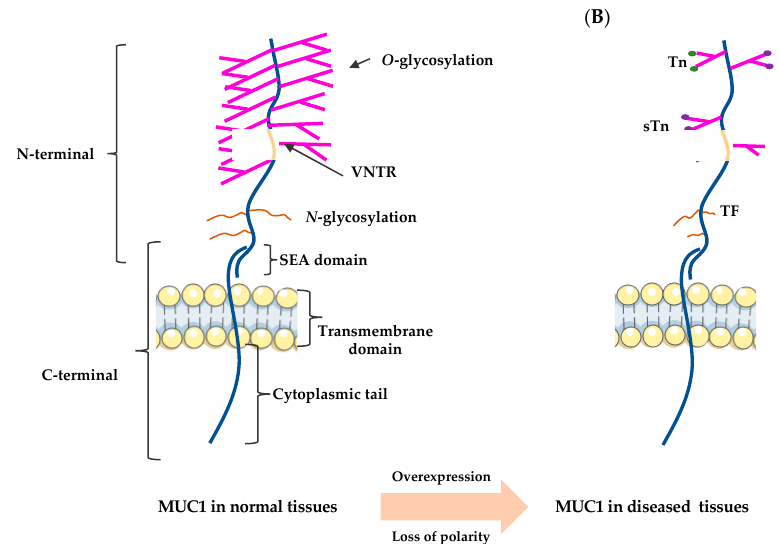
Figure 1. Structure of MUC1 in normal tissues and diseased tissues. ( A ) The structure of MUC1 in normal tissues; ( B ) The structure of MUC1 in diseased tissues.